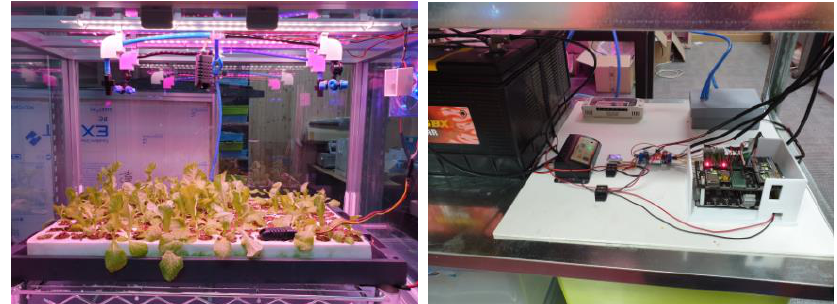
Figure 21. Plant factory with integrated technology.